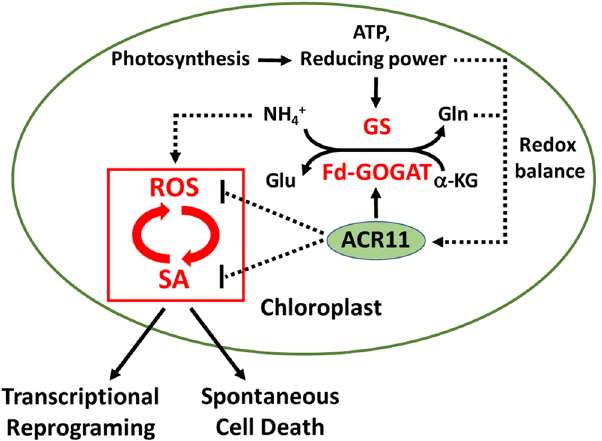
Figure 8. A hypothetical working model of ACR11 function in modulating reactive oxygen species (ROS) production and salicylic acid (SA)-associated defense responses. ACR11 may integrate the information of glutamine homeostasis and redox balance to modulate the activities of glutamine synthetase (GS)/ferredoxin- dependent glutamine oxoglutarate aminotransferase (Fd-GOGAT) and ROS production in the chloroplast. Overproduction of ROS activates SA biosynthesis and enhances SA-associated defense responses. In addition, ACR11 may directly affect SA biosynthesis, which in turn affects ROS production and SA-associated defense